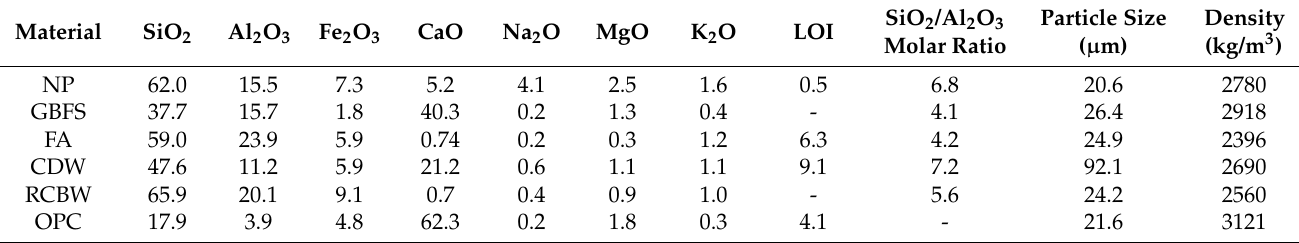
Table 1. Chemical composition (XRF) of the raw materials (construction and demolition waste (CDW) and ordinary Portland cement